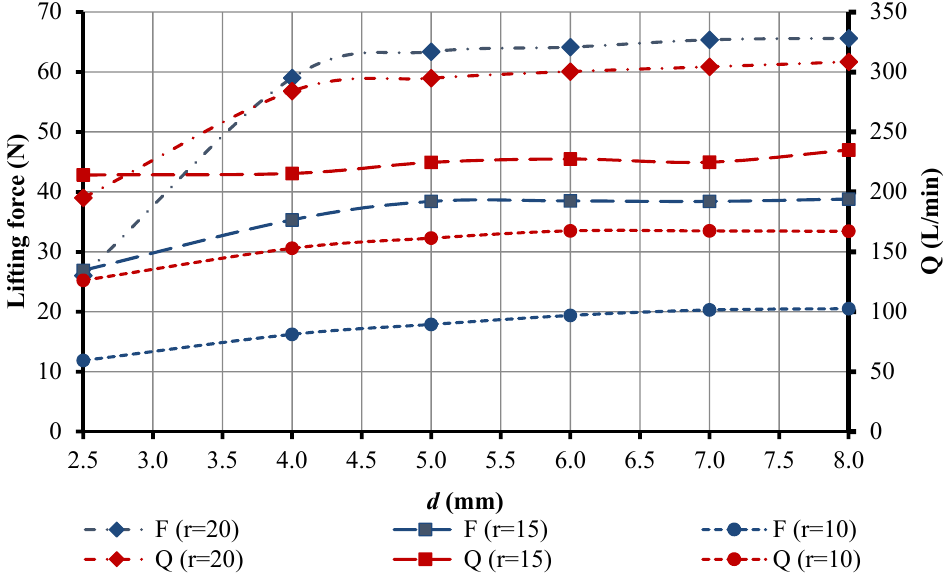
Figure 15. Effects of fitting diameters and constrictions on BGD flow and power characteristics at different conical insert radii.